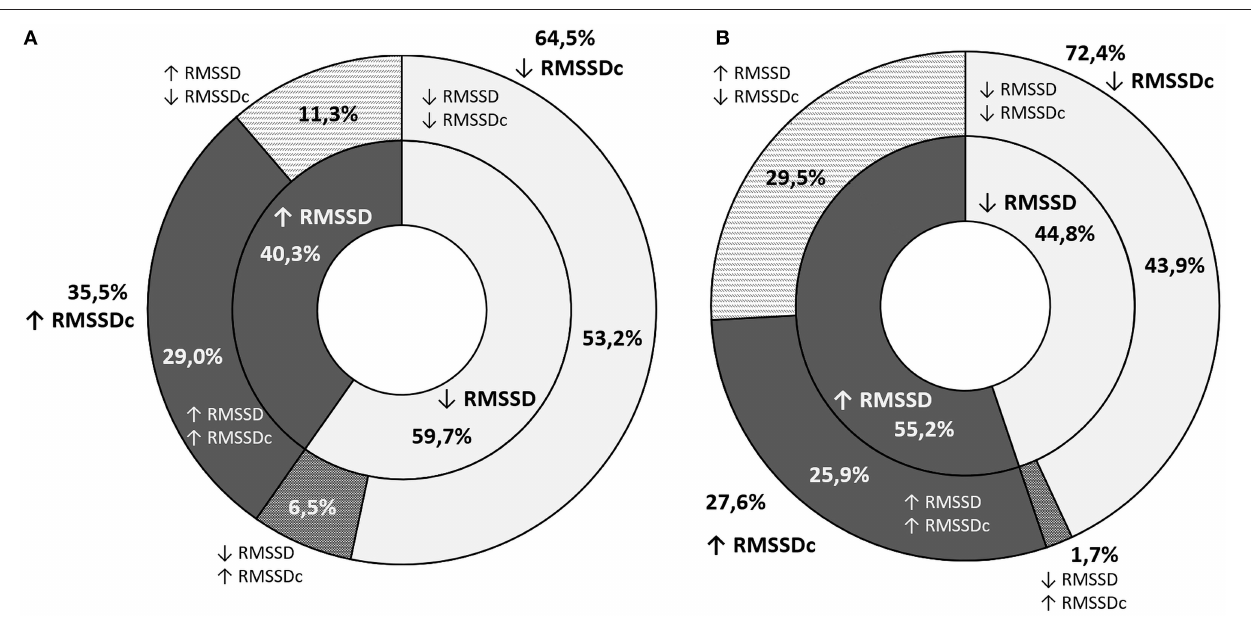
FIGURE 2 | A graphic representation of the proportion of students with an increase or decrease in RMSSD (inner ring) and RMSSDc (outer ring) throughout the observation period (A) graph stands for boys and (B) one for girls.